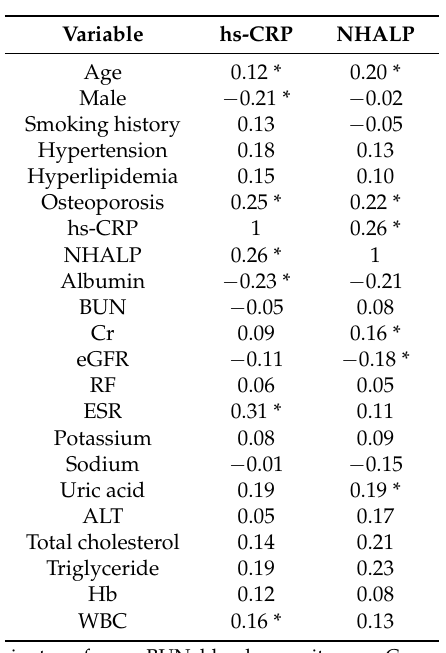
Table 2. The correlation coefficients between serum hs-CRP, non hepatic alkaline phosphatase (NHALP) and various bio-clinical variables.